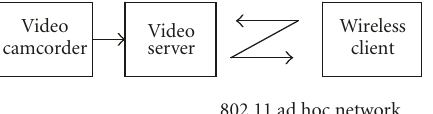
Figure 1: Wireless video streaming system.